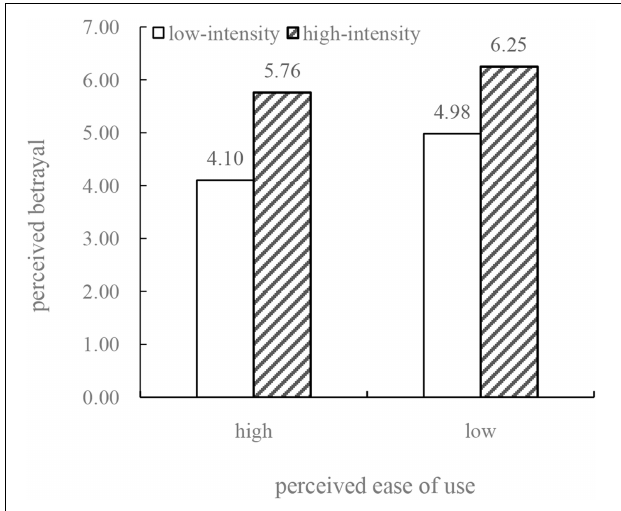
FIGURE 4 | The moderating role of perceived ease of